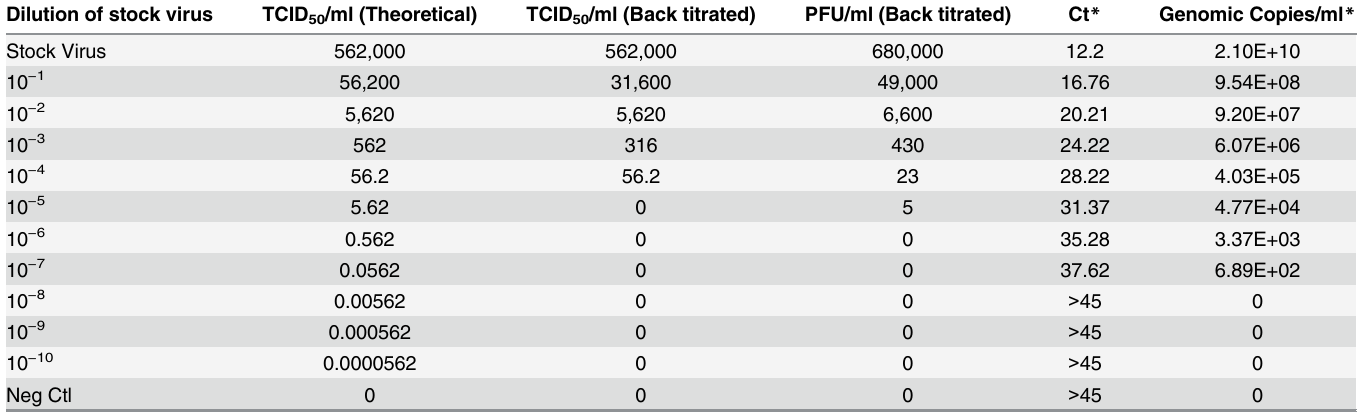
Table 1. Infectious titers, PCR Ct values and genomic copies/ml of serial dilutions of PEDV stock. Dilution of stock